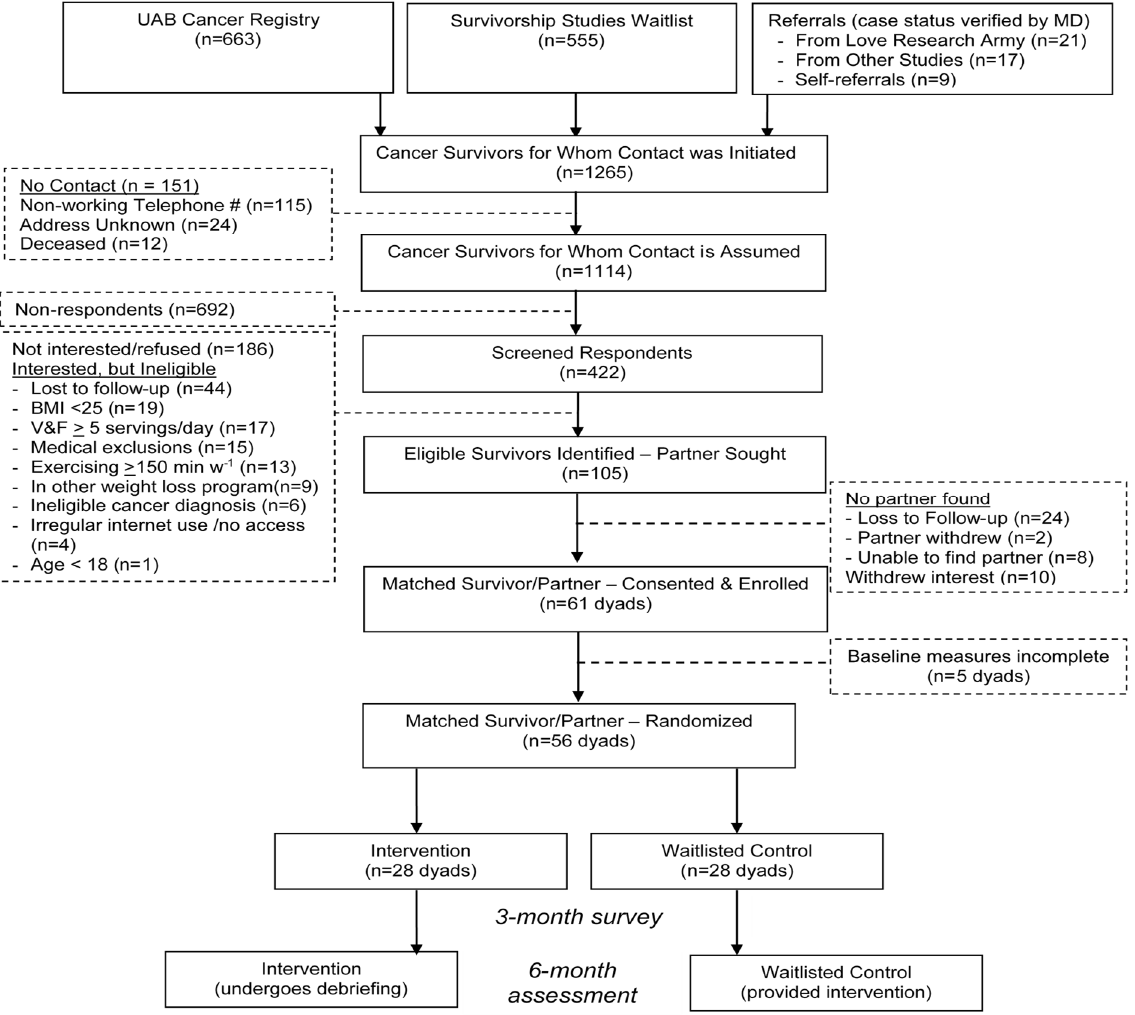
Figure 1. DUET study flow diagram that focuses on the enrollment trajectory.